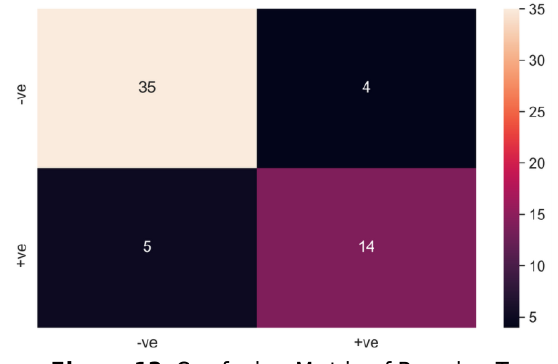
Figure 13. Confusion Matrix of Bagging Trees